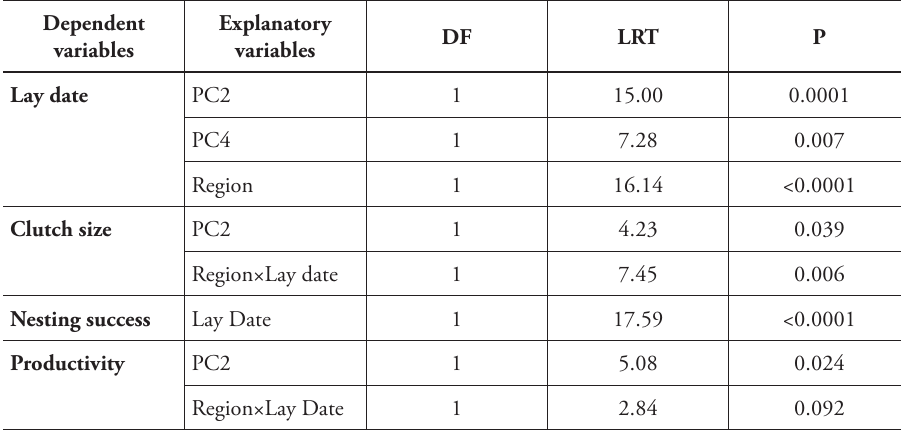
Table 3. Results of the Generalized Linear Mixed Models (GLMMs) testing for variations in lay date (15-day periods), clutch size, nesting success and productivity. “Year” was included as a random effect in all models. Initial models included region (coastal vs. interior-mountain), weather variables (PCs) and lay date (for clutch size, nesting success and productivity), as well as interactions between region and lay date. Stepwise backward model selection was performed based on AIC values. We present the results of final models.